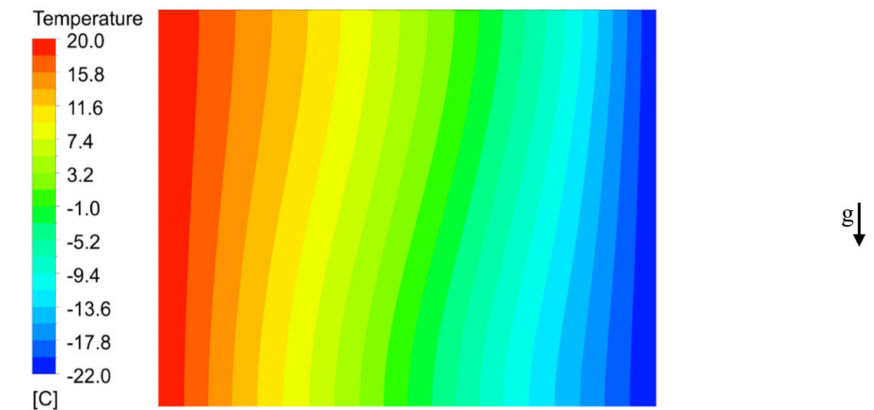
Figure 10. Temperature field on the side of the